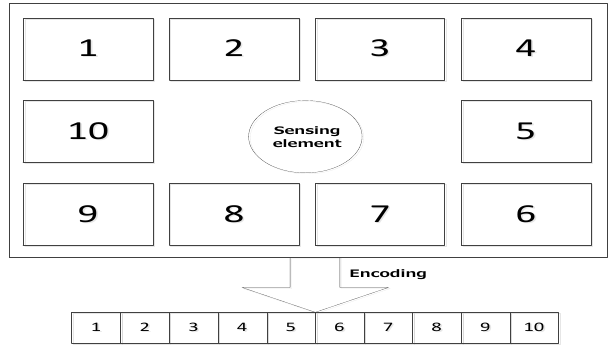
Figure 4. The simplified model for layout optimization and the way of